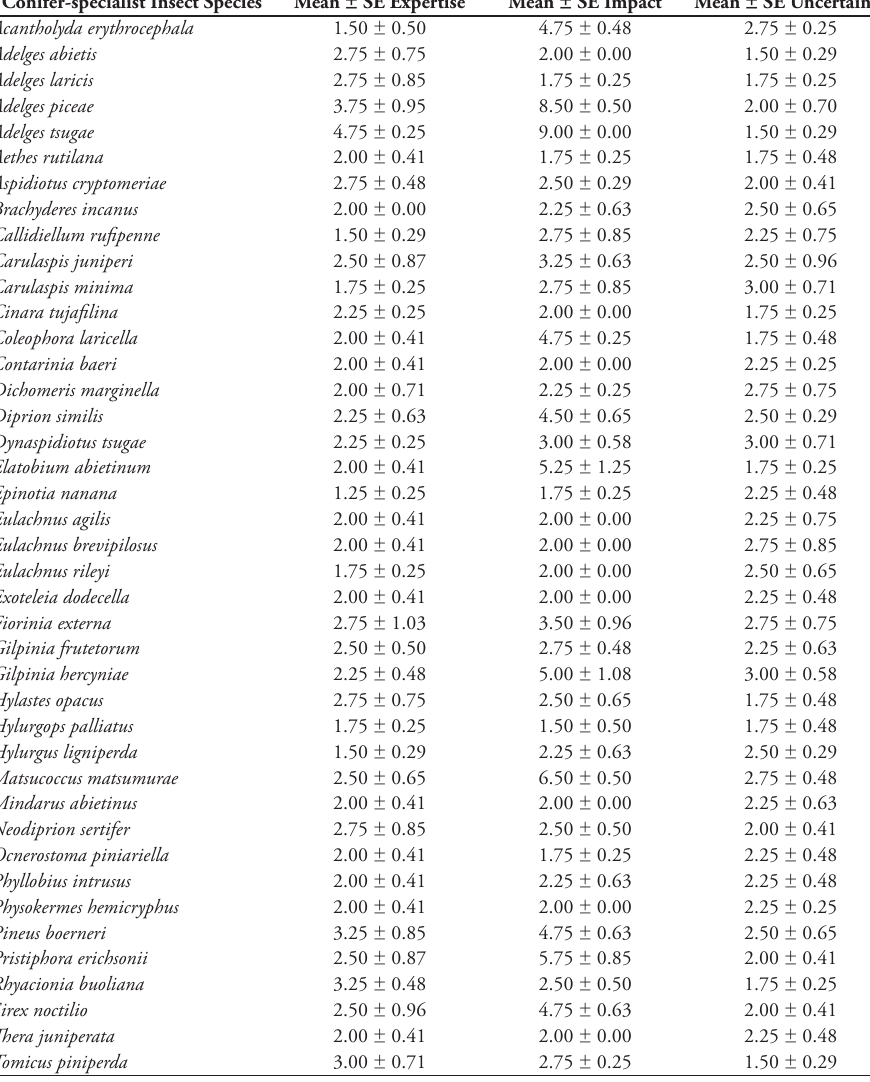
Table 1. Summary of descriptive statistics (mean ± SE) for the self-assessed level of expertise (range of 1–5, in which 1 is no expertise and 5 is high expertise), impact level (range of 1–9, in which 1 is no docu- mented damage and 9 is functional extinction of the host plant), and self-assessed level of uncertainty (scale of 1–5, where 1 is low uncertainty and 5 is high uncertainty) for each insect species assessed in this